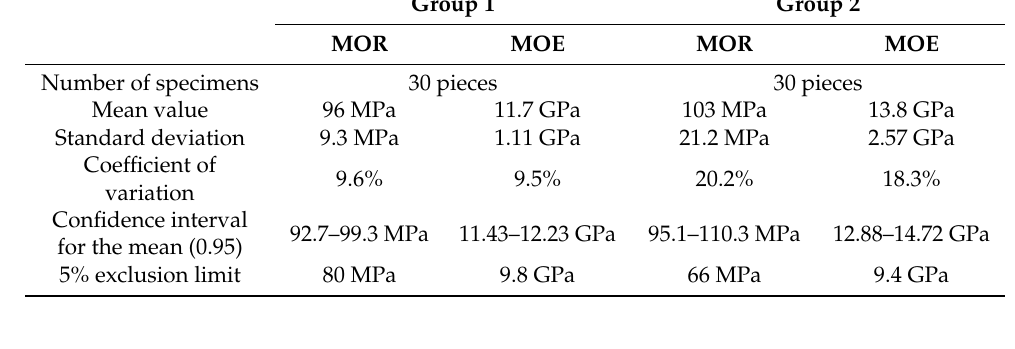
Table 13. Estimates for regression models of FF and RM with MOR as the predictor.